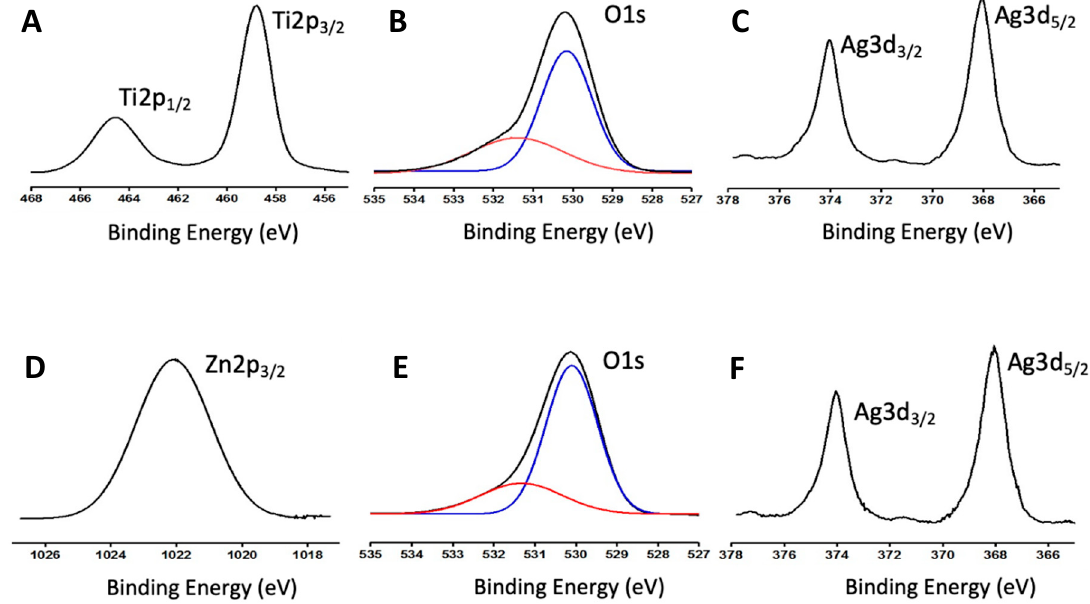
Figure 5. X-ray photoelectron spectroscopy (XPS) spectra of Ti 2p 1/2 , O 1s, Ag3d 3/2 , Ag3d 5/2 taken from the 10%Ag@TiO 2 NW catalyst ( A – C ), and Zn 2p 1/2 , O 1s, Ag3d 3/2 , and Ag3d 5/2 taken from the 10%ZnO NW composite ( D – F ).